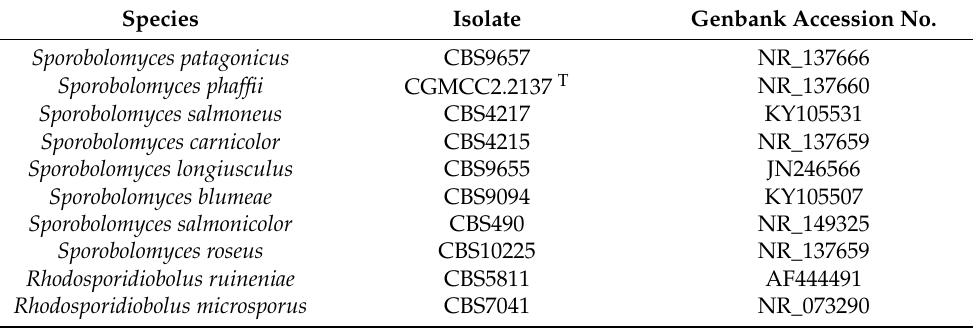
Table 1. GenBank accession numbers of sequences of the Sporobolomyces spp. strains used as references in phylogenetic